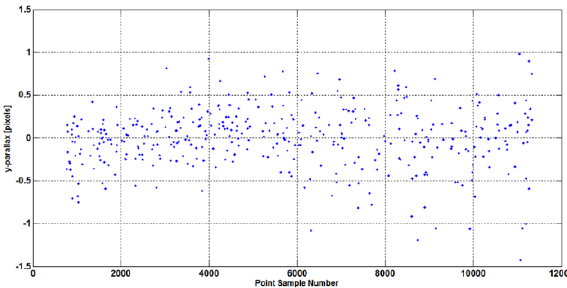
Figure 4: Scatter pattern of y-disparities of the manually measured points As Fig. 4 indicates, the values of